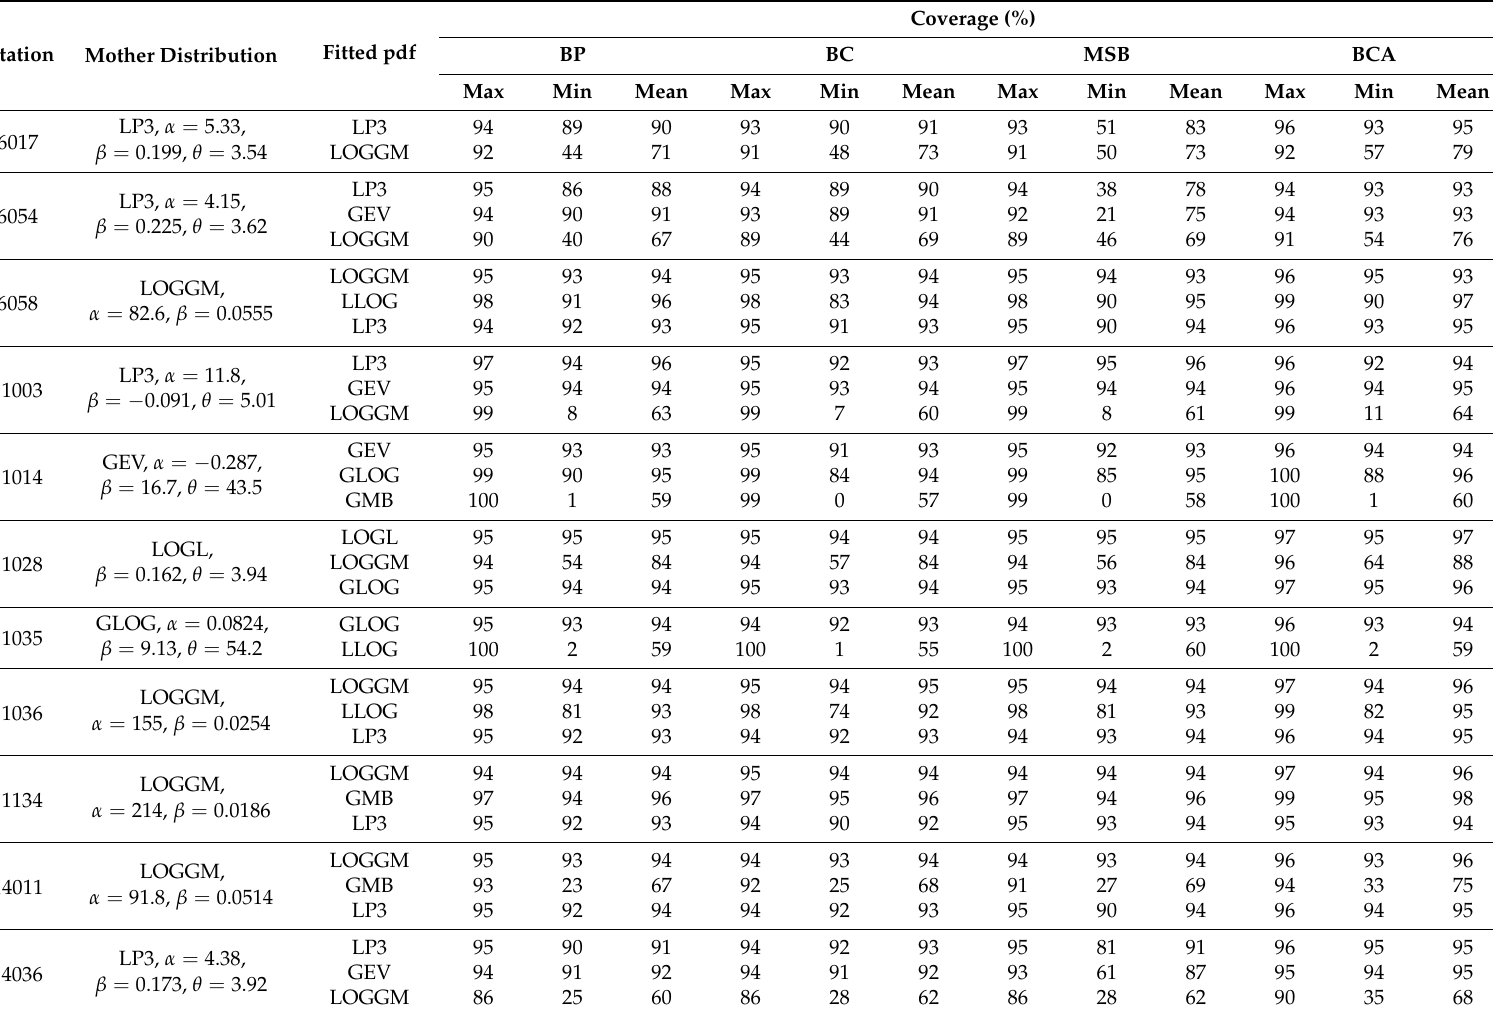
Table 4. Coverages obtained for different mother distributions and fitted